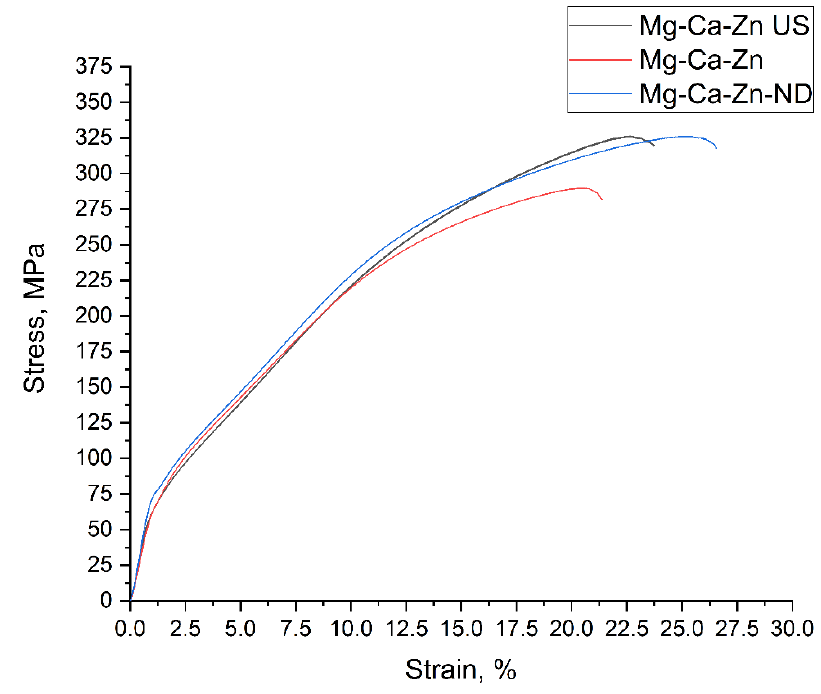
Figure 6. Diagrams of compression tests of magnesium alloys Mg – Ca – Zn. Table 2. Mechanical properties of the obtained magnesium alloys.